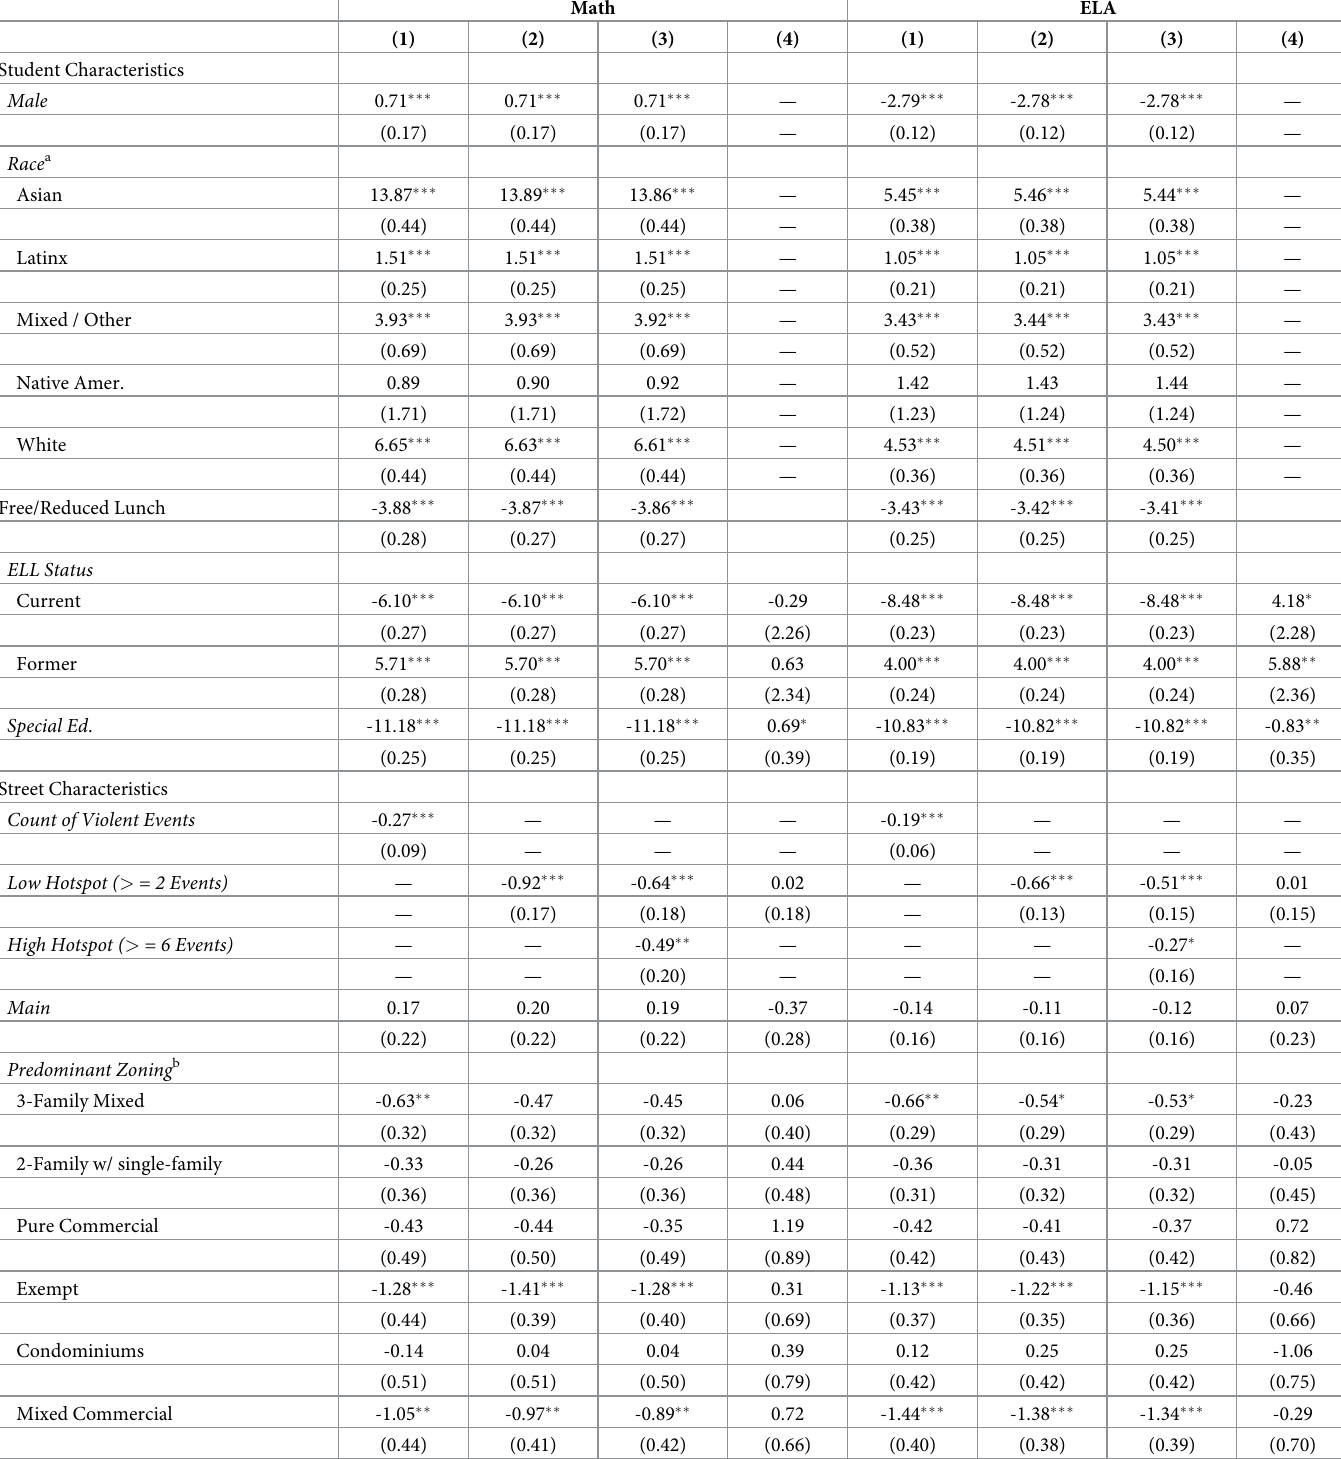
Table 2. Complete parameter estimates from linear models predicting scores on MCAS tests across grades and school years, based on characteristics of the student and street and tract of residence, with and without student-level fixed